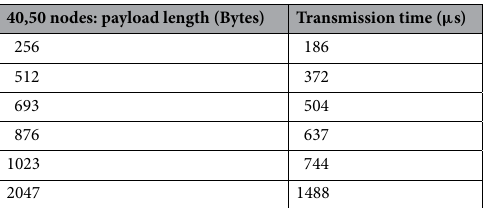
Table 1. Payload length and transmission time based on data rate (11 Mbps) for 40 nodes and 50 nodes.